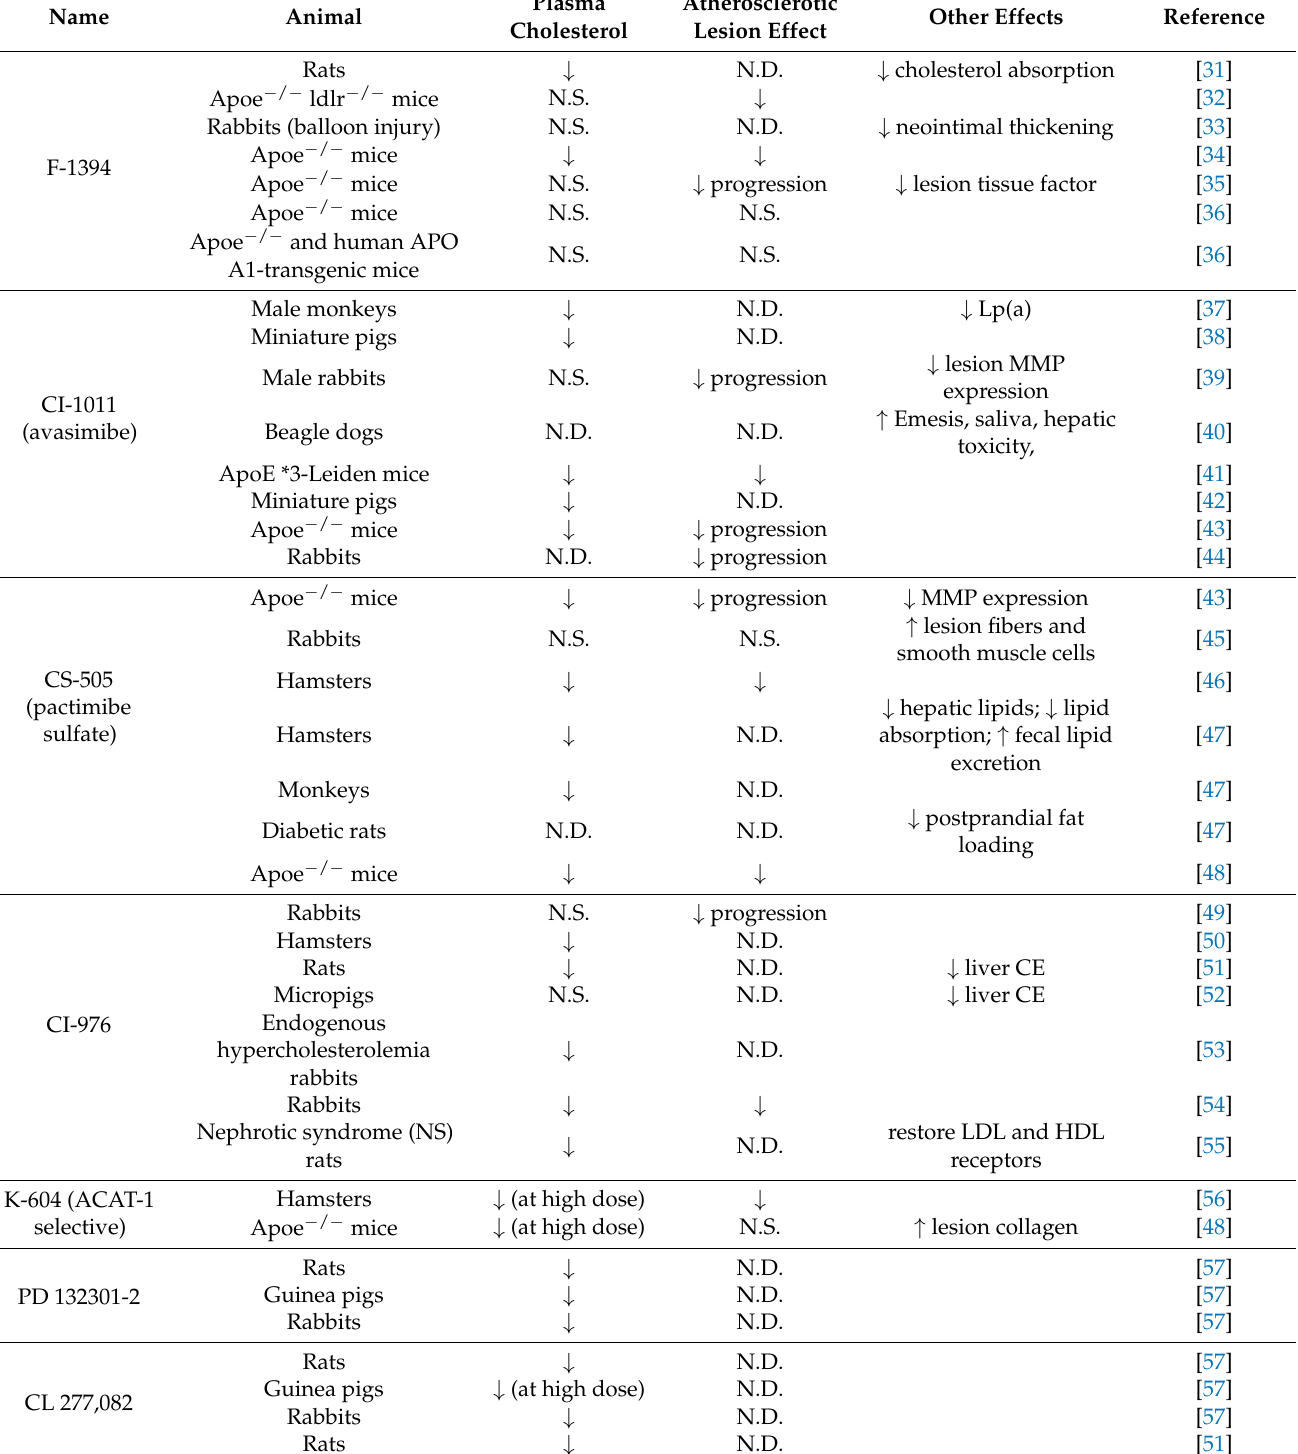
Table 1. Pre-clinical studies of the main ACAT inhibitors for